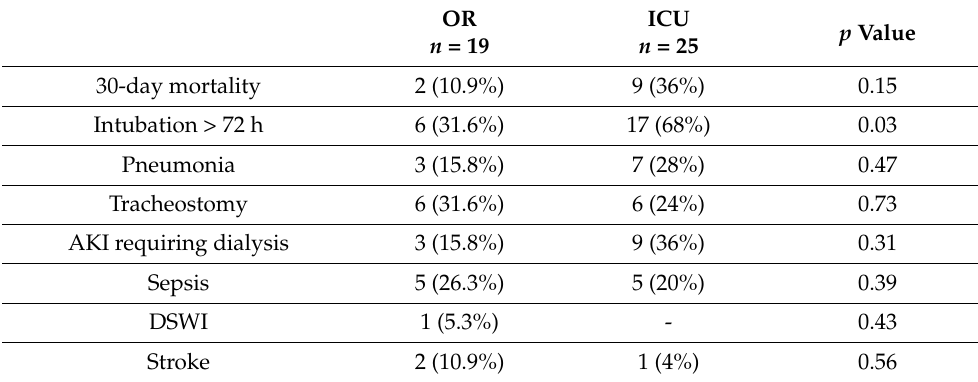
Table 6. Outcomes of planned re-explorations analyzed by OR versus ICU.